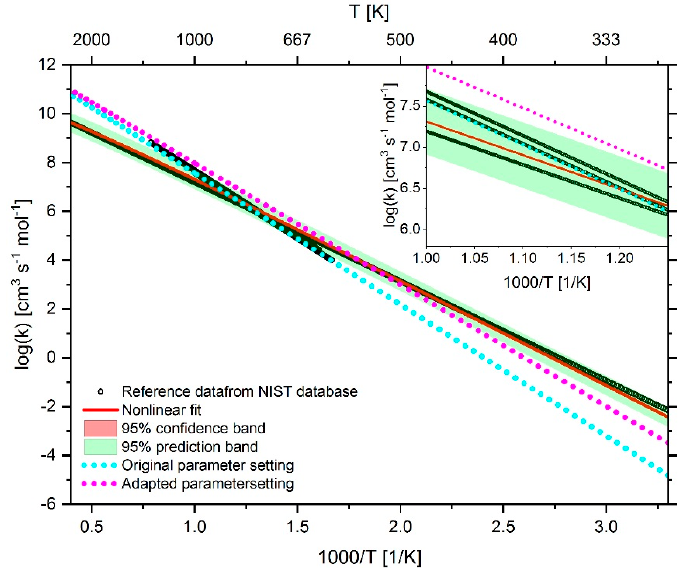
Figure 24. Comparison of the reaction rate coe ffi cient of reaction 45 (CH 4 + HO 2 ↔ CH 3 + H 2 O 2 ) before and after adaptation as well as the fitted rate coefficient using reference data from the NIST database.